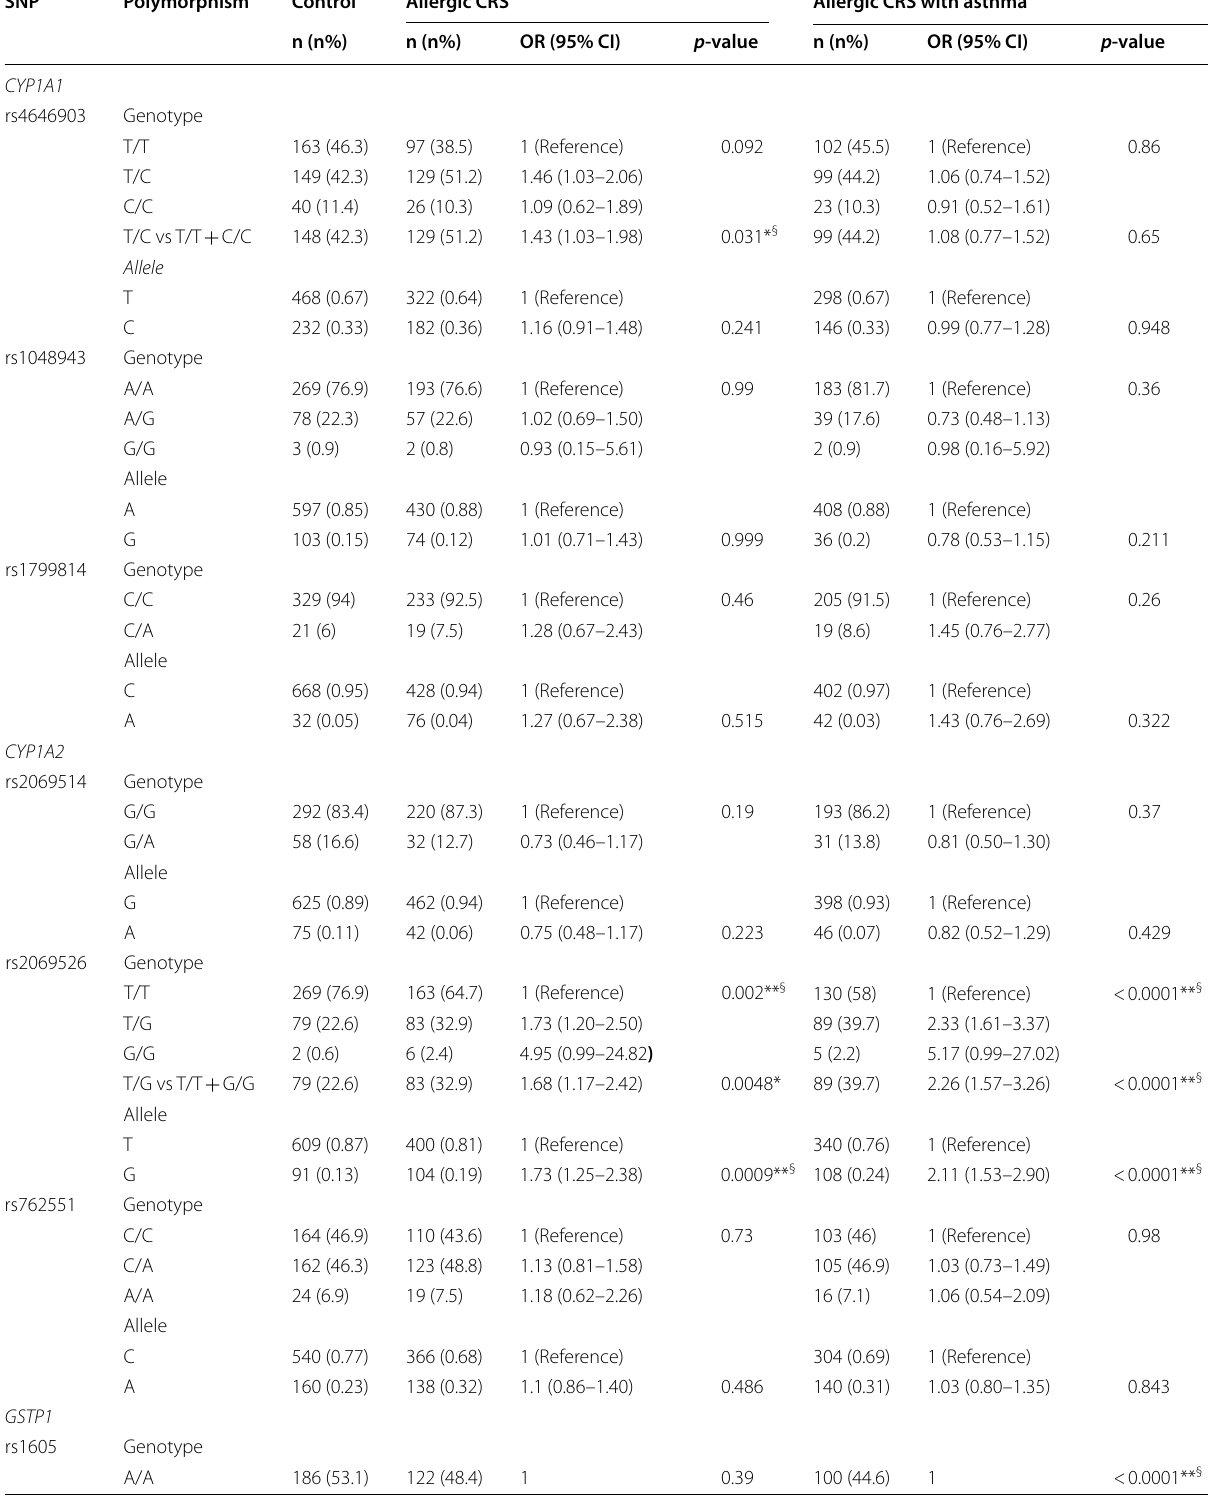
Table 3 Allelic and Genotypic association of CYP1A1 , CYP1A2 and GST gene variants in cases with allergic CRS, and allergic CRS with asthma and